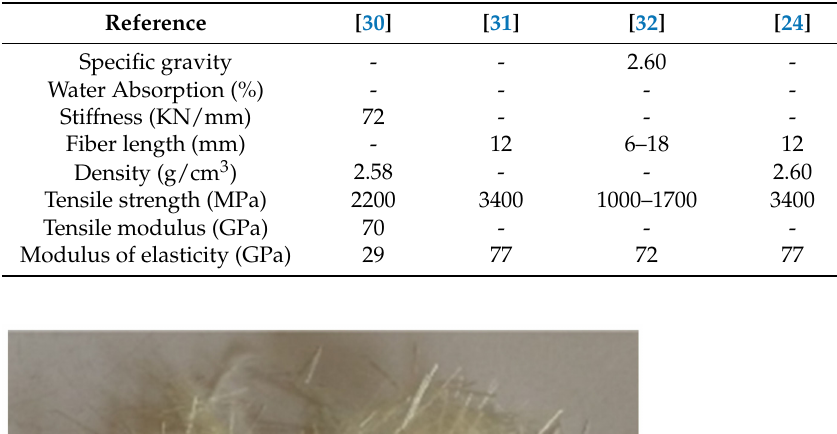
Table 1. Physical properties Glass Fibers (GF).